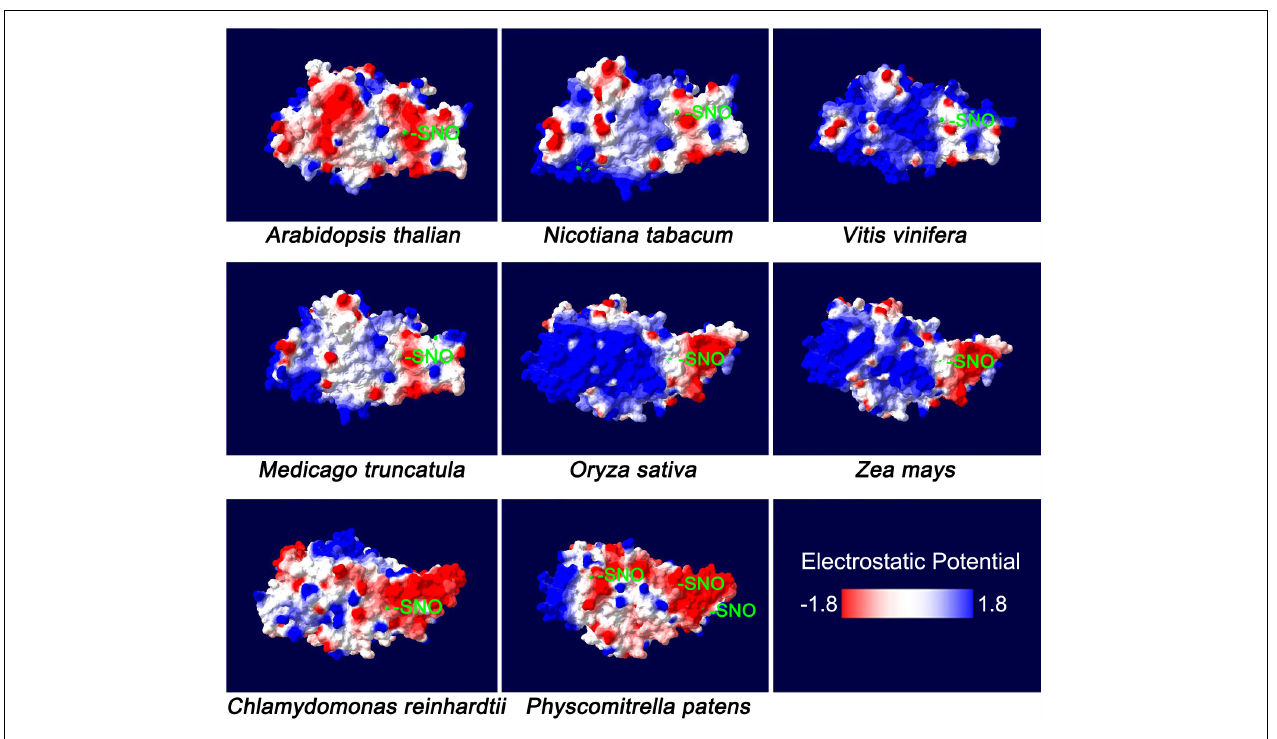
FIGURE 1 | The molecular surface of plant nitrate reductase. The NR sequences of Arabidopsis thaliana (Accession ID: X13434.1), Nicotiana tabacum (XP_016462202.1), Vitis vinifera (XP_019082269.1), Medicago truncatula (XP_003614820.1), Oryza sativa Japonica Group (XP_015650300.1), Zea mays (NP_001292785.1), Chlamydomonas reinhardtii (AAF17595.1) and Physcomitrella patens (XP_001763055.1) were selected for the analysis of homology models which were constructed in the SWISS-MODEL Workspace (http://swissmodel.expasy.org/workspace/). The molecular surface and the electrostatic potential were computed with Swiss-PdbViewer v. 4.0.1 software (Biasini et al., 2014). The colors on the molecular surface indicate electrostatic potentials (red: –1.8; blue: +1.8). The cysteine (Cys) residues are marked with light-green color, some of which may be subjected to S -nitrosylation